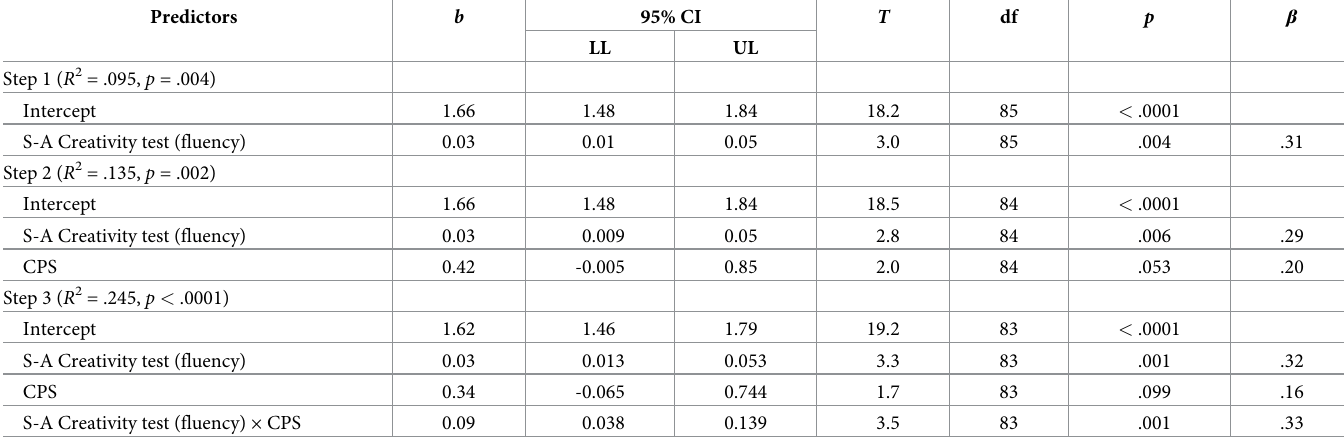
Table 4. Results of multiple regression analysis in the effect of fluency with creative achievement score as the objective variable.